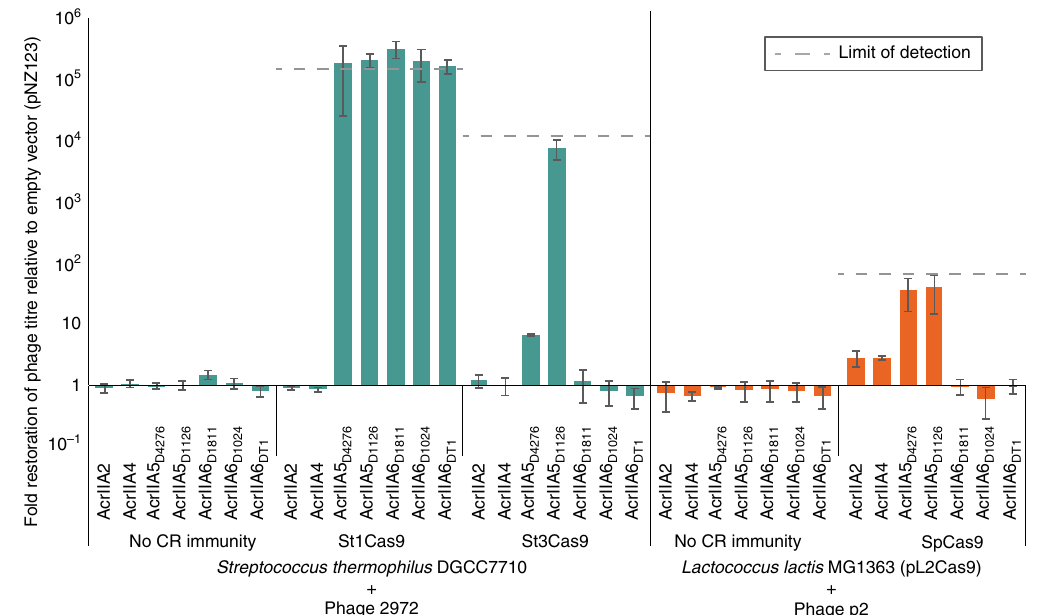
Fig. 4 Comparison of type II-A Acr activities. Fold restoration of phage titres on strains carrying an Acr over ones carrying only the empty vector. The size of the bar re fl ects how effective the Acr is at bypassing the CRISPR immunity present, and each is the average of three biological replicates, each of three technical triplicates. The error bars represent the standard deviation. The leftmost three sections (green) are the relative titres of phage 2972 when its host is not immunized, or immunized at the endogenous CR1 or CR3 locus. The rightmost two sections (orange) are the relative titres of phage p2 when its host is not immunized, or immunized using an exogenous plasmid-borne SpCas9. Each system (CR1, CR3, SpCas9) varies in effectiveness, so the threshold limits of detection for each is indicated by a dotted